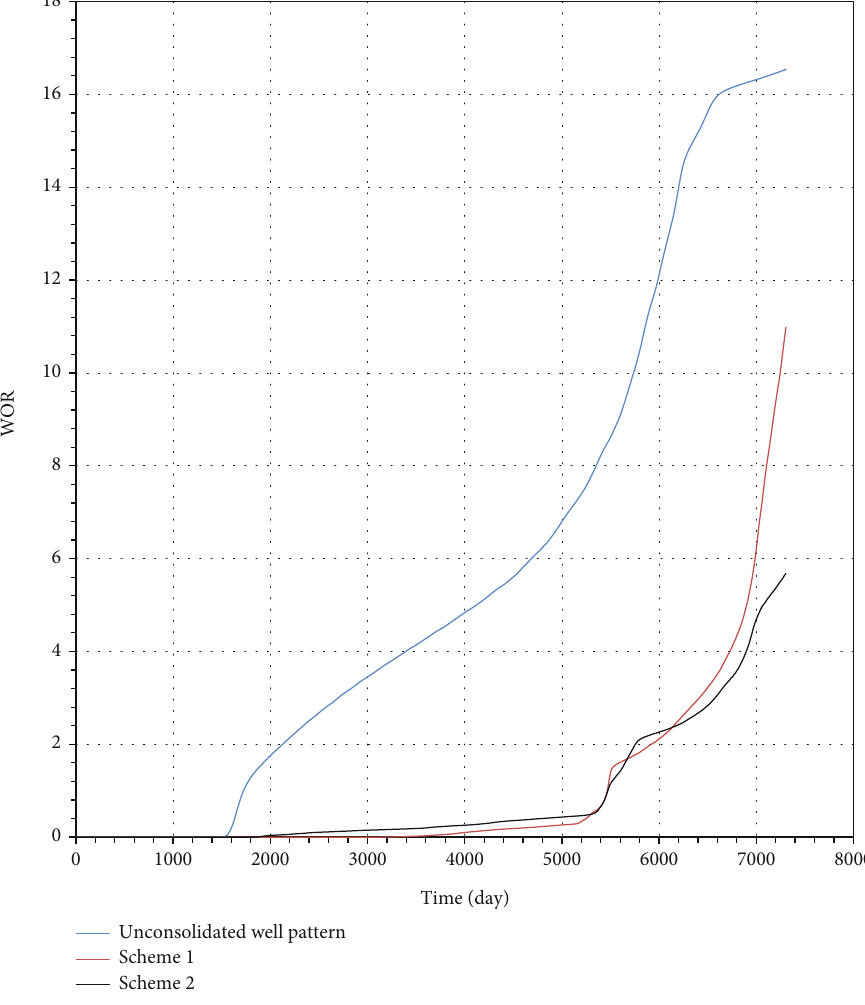
Figure 14: The relationship between production time and